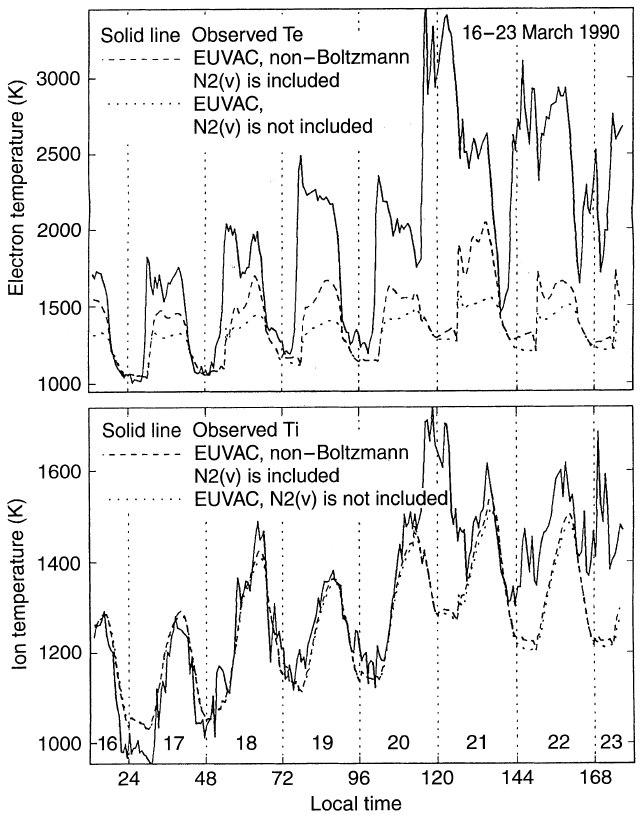
Fig. 6. The measured ( solid lines ) and modeled ( dashed and dotted lines ) electron ( top ) and ion ( bottom ) temperatures at the F2 peak altitude on 16–23 March 1990 for the EUVAC solar flux model. The dashed lines show results when the non-Boltzmann populations of the first five vibrational levels of N 2 ( v ) are included in the model, and the dotted lines are ones without the effects of vibrationally excited N 2 on the loss rate of the O (cid:135) (cid:133) 4 S